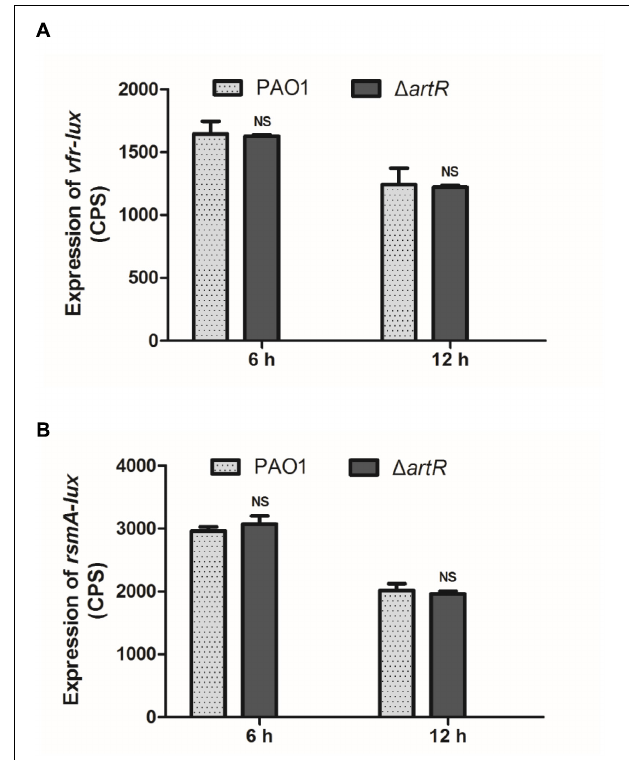
FIGURE 3 | Expression of vfr and rsmA in PAO1 and (cid:49) artR . (A) The expression of vfr in PAO1 and (cid:49) artR . (B) The expression of rsmA in PAO1 and (cid:49) artR . Strains carried reporter plasmids pKD- vfr or pKD- rsmA were cultured in LB medium. Promoter activities were measured after 6 and 12 h growth. Error bars represent one standard deviation from the mean. NS p > 0.05 compared to the wild-type.